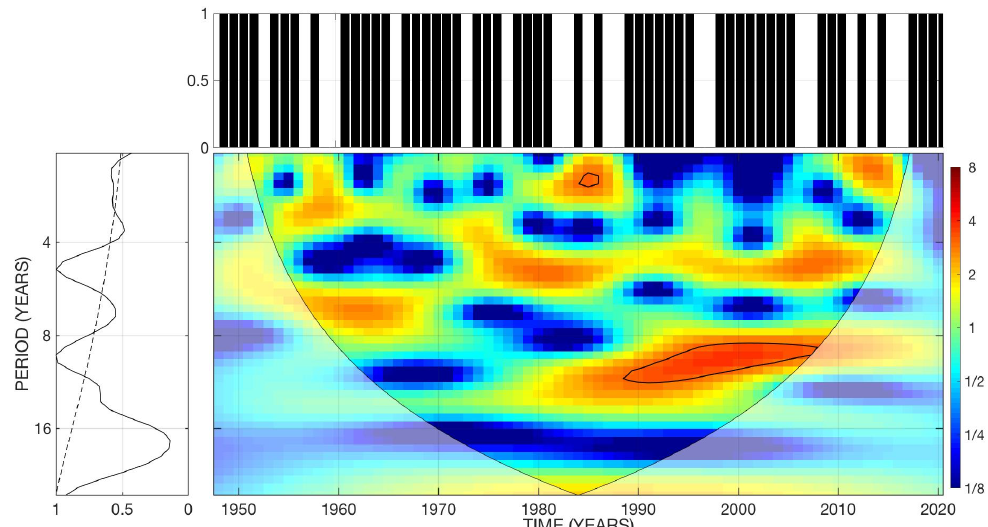
Figure 7. Time-frequency wavelet results of category 2 Atlantic hurricanes between 1950 and 2021. The digital time series for category 2 Atlantic hurricanes is shown in the upper panel. The global wavelet spectrum is shown in the left panel. The central panel shows the calculated wavelet Power Spectral Density (PSD) in normalized units adopting the red-green-blue color scales. The Cone Of Influence (COI, “U”-shaped curve with shaded outer zones) shows the possible edge effects in the PSD. The time-frequency regions with wavelet spectral power detection above 95% confidence level are marked with thin black contours.